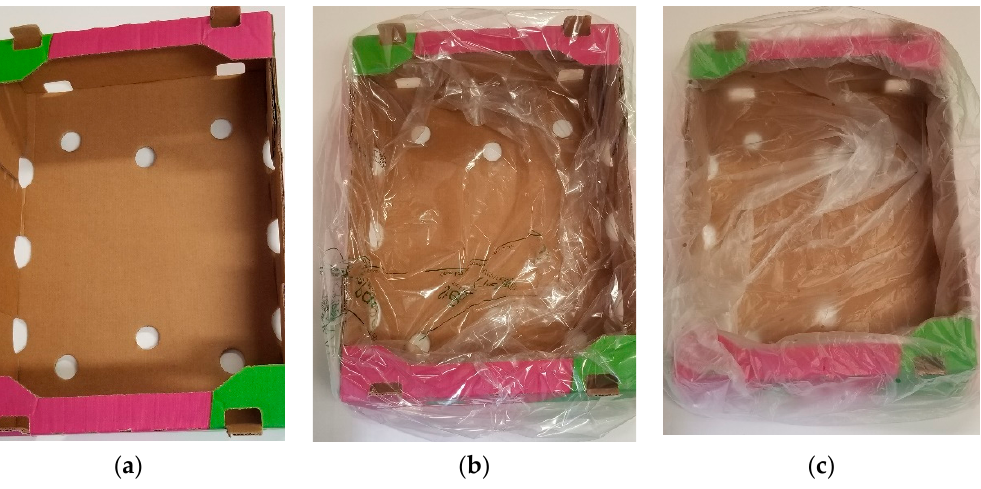
Figure 1. Pomegranate fruit (cv Wonderful) packaging treatments ( a ) without a polyliner in standard open top ventilated cartons, ( b ) with a microperforated Xtend ® liner (20 µmm perforation) in standard open top ventilated cartons and ( c ) with a macroperforated high density polyethylene liner (4 mm perforation) in standard open top ventilated cartons. Table 1. Summary of treatment combinations applied on ‘Wonderful’ pomegranate before cold stor-